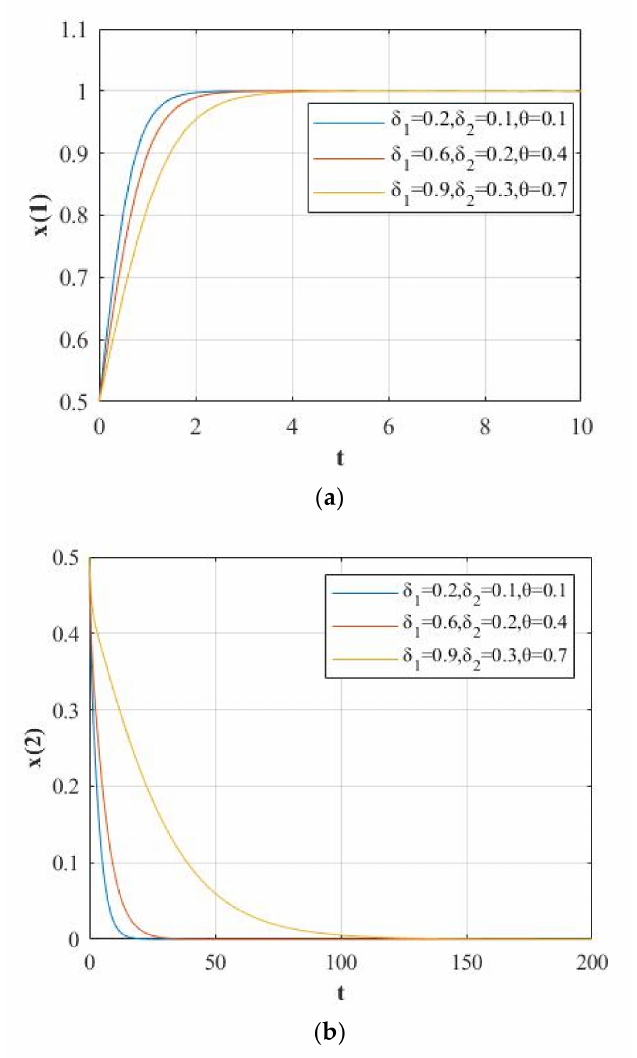
Figure 10. ( a ) While changing δ 2 , θ , and δ 1 , evolution diagram of government’s supervision option. ( b ) While changing δ 2 , θ , and δ 1 , evolution diagram of platform’s supervision